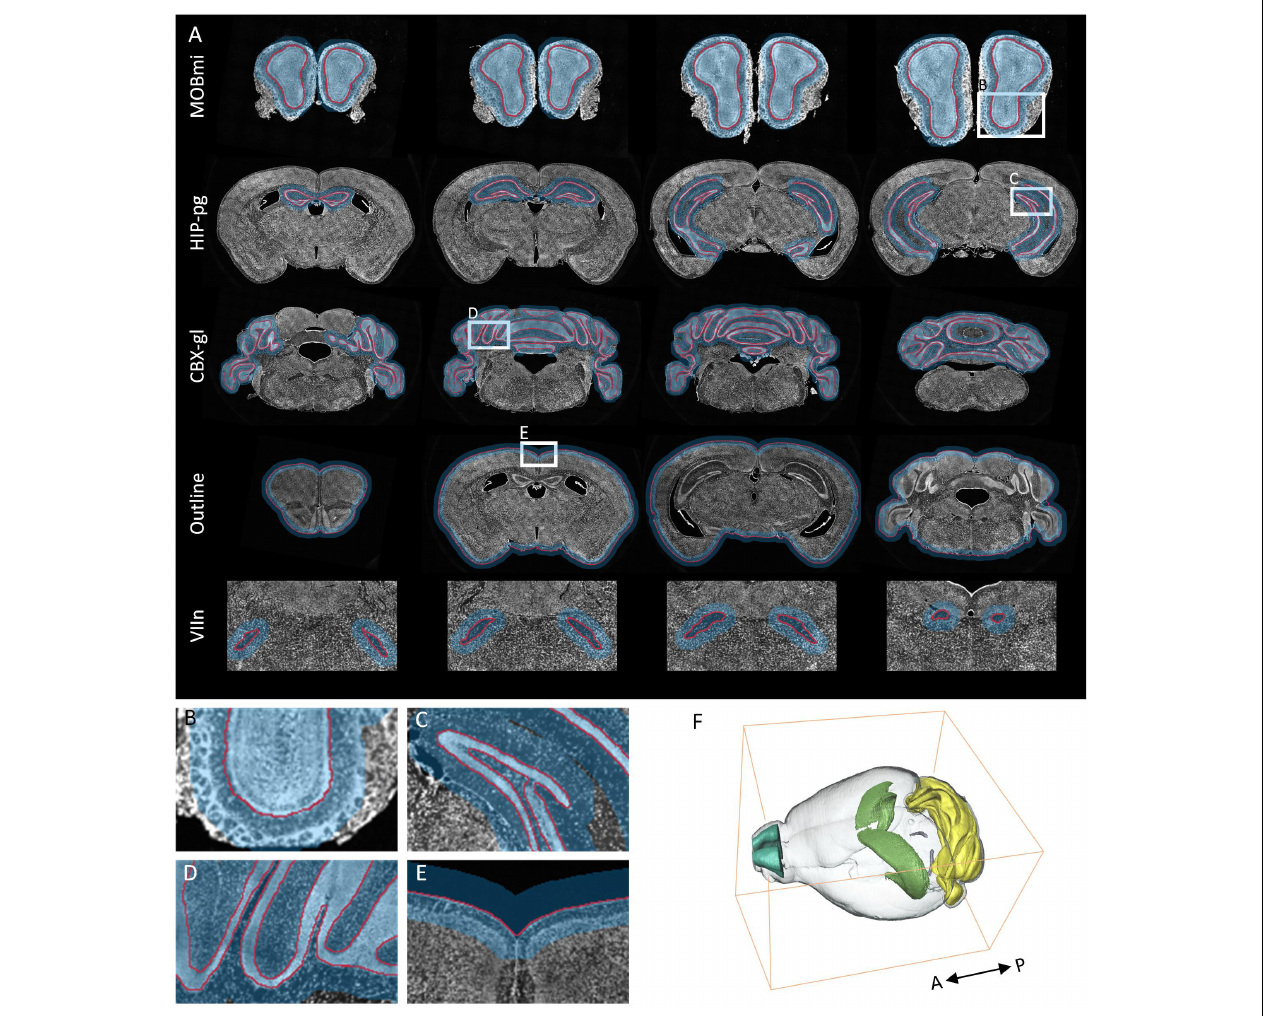
FIGURE 5 | Segmentation effects for brain-wide regions. (A) The segmentation effects for five brain regions. From top to bottom: MOBmi, HIP-pg, CBX-gl, VIIn, and outline, each of which are shown as the superposition of four typical coronal images, localization masks, and segmented lines. (B–E) Enlarged views of the white boxes in A . (F) A 3D reconstruction of the segmentation results of the five brain